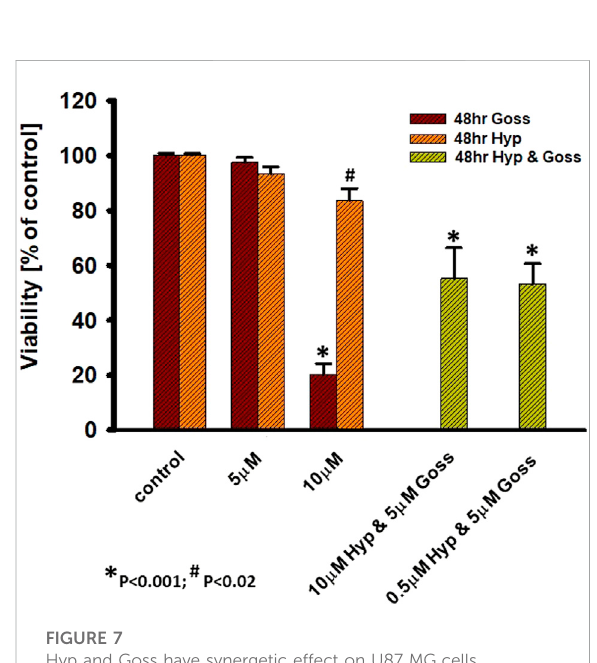
FIGURE 7 Hyp and Goss have synergetic effect on U87 MG cells viability. Cell viability in the presence of Hyp and Goss for 48